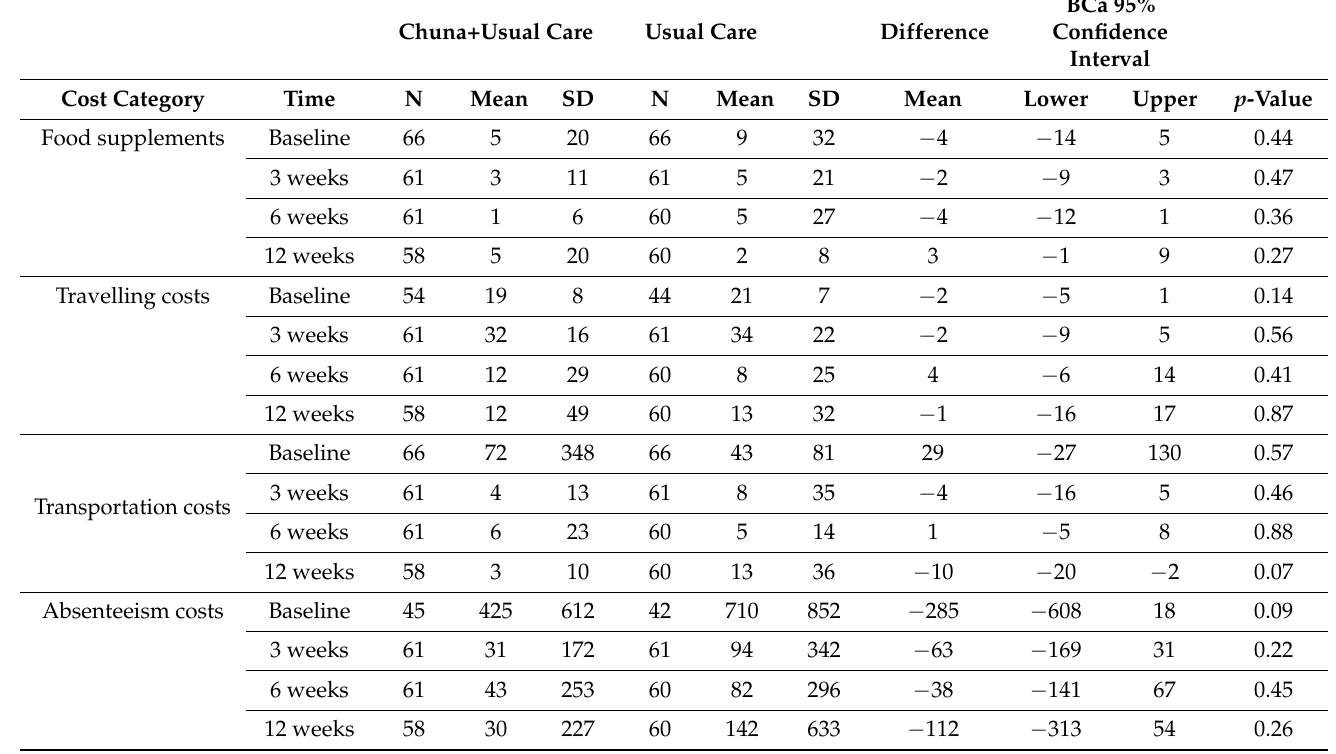
Table 2. Societal costs at four